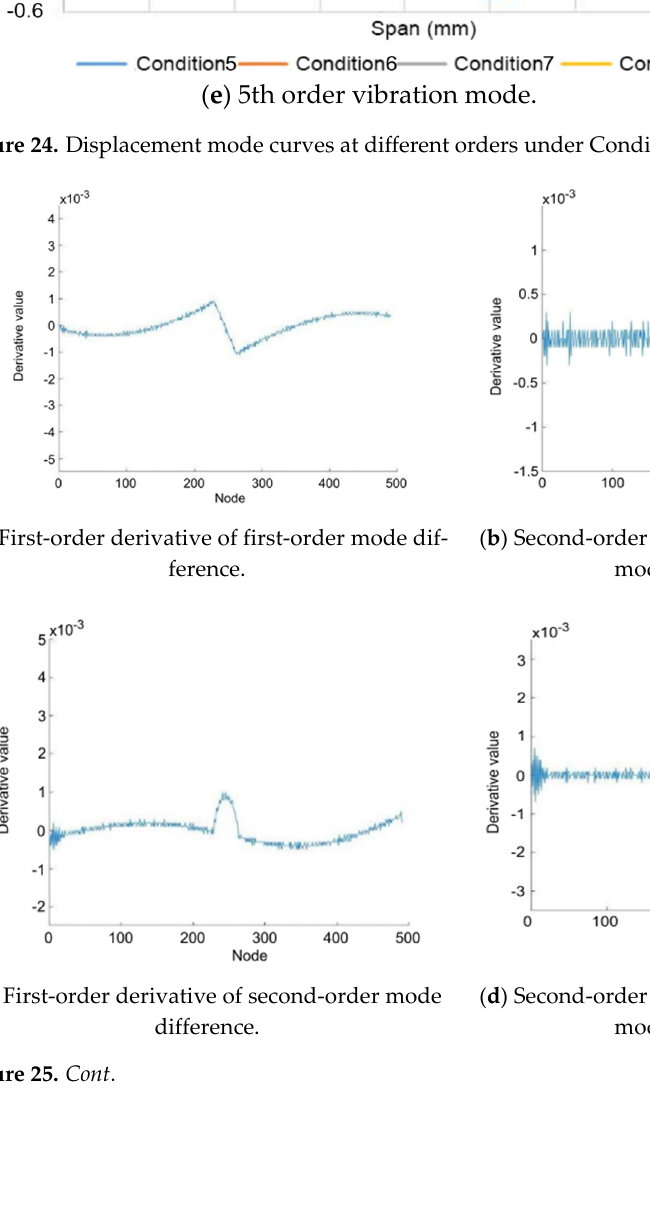
Figure 24. Displacement mode curves at different orders under Conditions 5 to